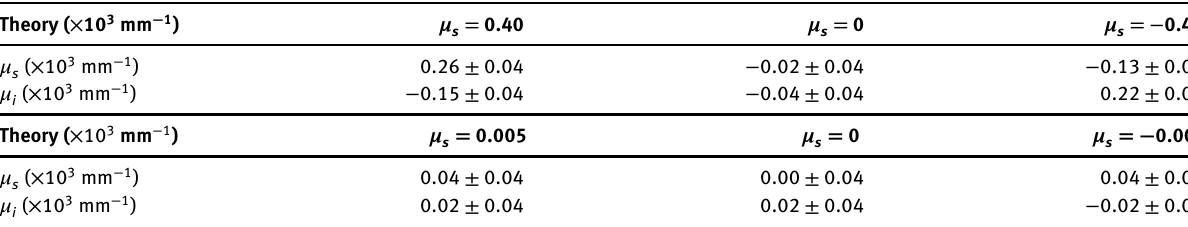
The top (bottom) three rows correspond to coherence length 𝛿 s = 0.56 mm ( 𝛿 s = 5.0 mm). The expected twist phase for 𝛿 s = 5.0 mm is smaller than our experimental precision. The idler beam takes on a twist phase that is consistent with the conjugation of the seed twist